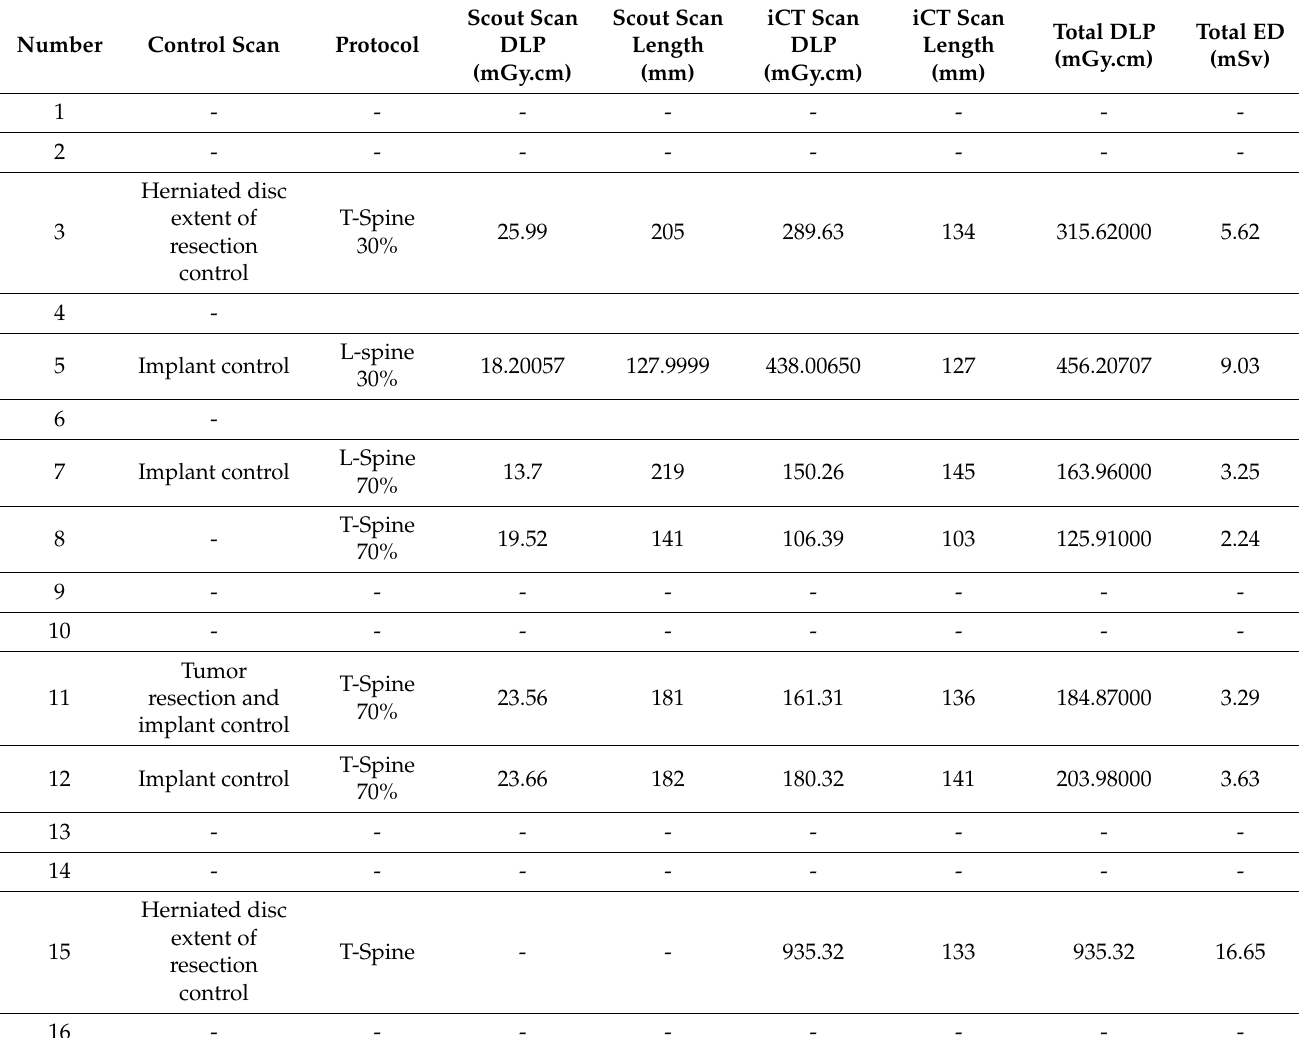
Table 3. Scan length and DLP of scout and control scan, and total effective dose with fused image datasets with iCT registration and visualized objects in augmented